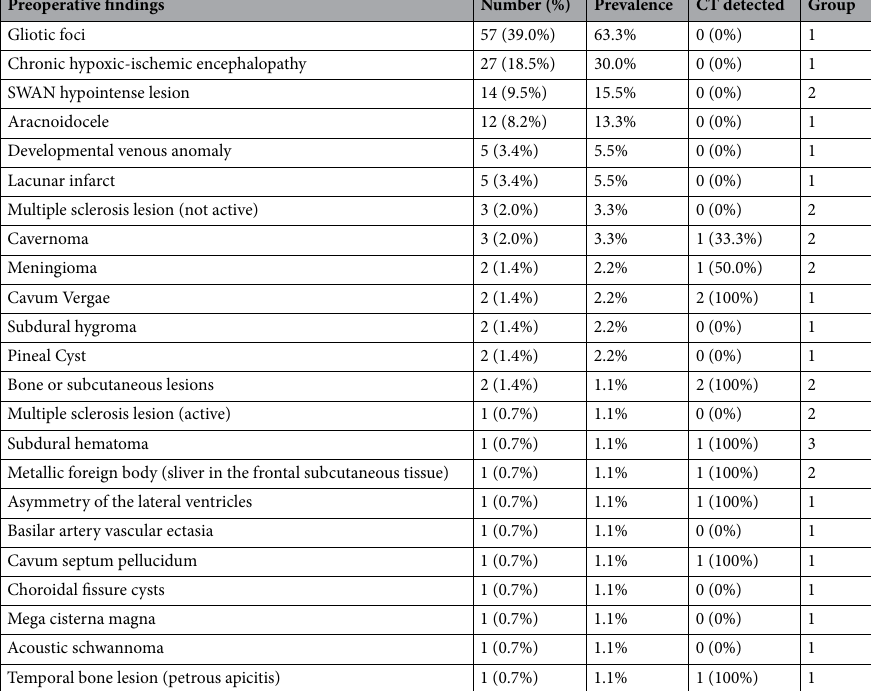
Table 3. Number and prevalence of preoperative findings in candidates for